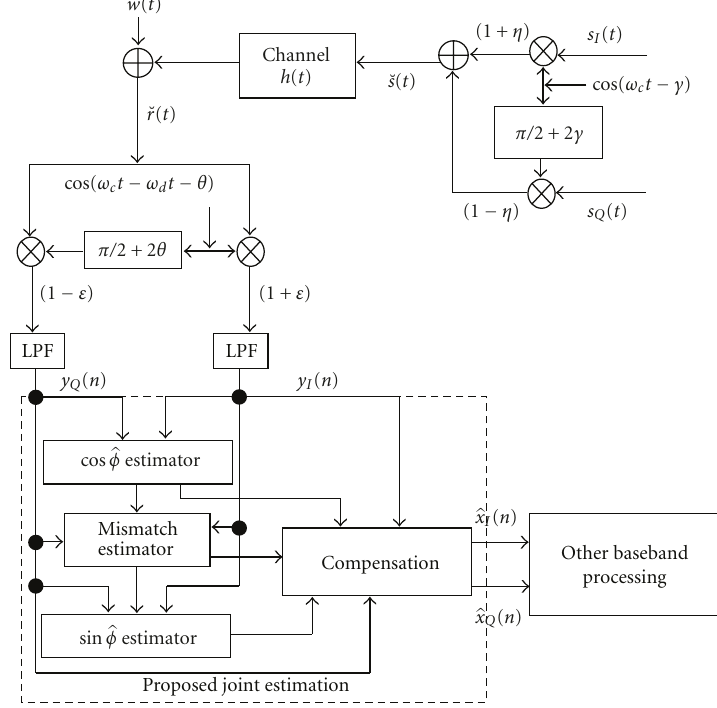
Figure 1: Block diagram of an OFDM system showing CFO and I/Q mismatch, and the proposed estimators.